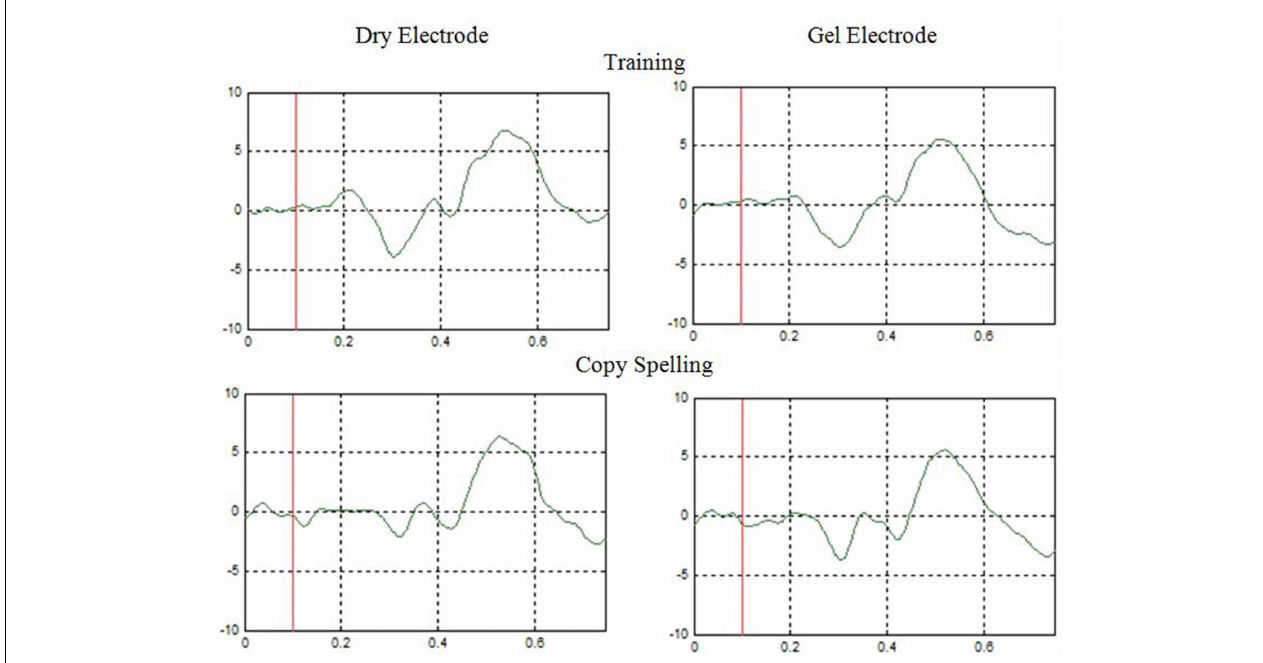
FIGURE 4 |The P300 complex recorded with dry and gel electrodes for one subject over site Cz. Each figure reflects averaged data across all target flashes for one five-letter word (150 flashes).The y -axis is scaled with ± 10 μ V, and the x -axis in presented in seconds.